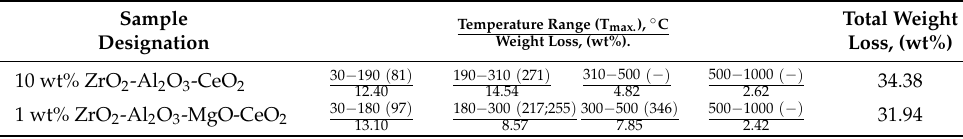
Table 2. Data of differential scanning